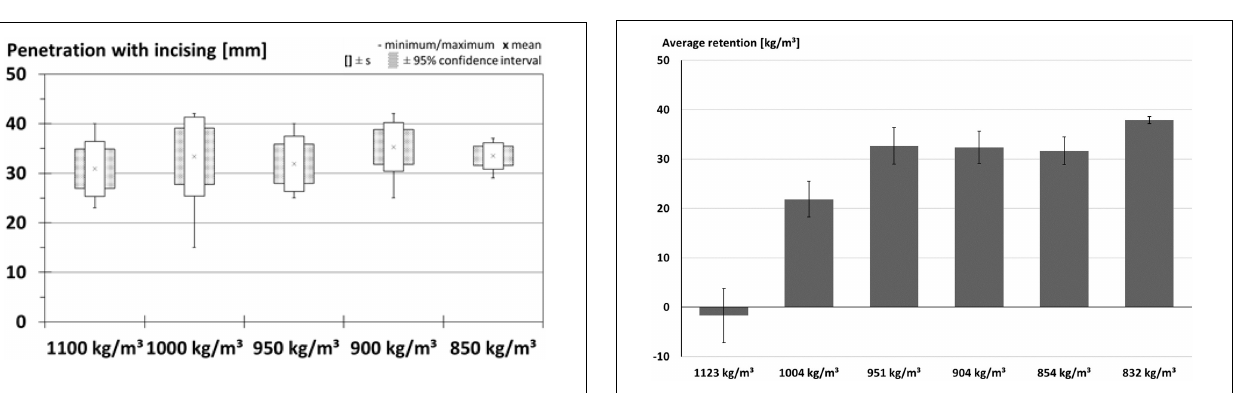
FIGURE 12 | Average retention in kg/m 3 of the alternative oily preservative after 2nd impregnation at different gross